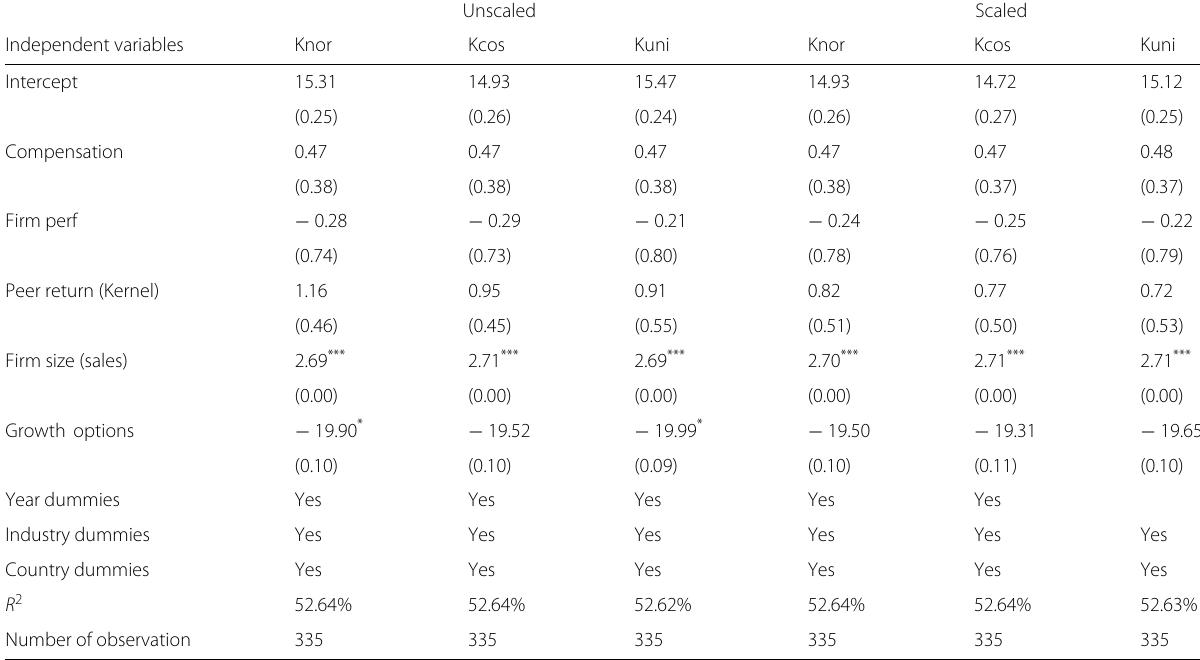
Table 15 Logit regression of RPE usage in executive compensation contracts